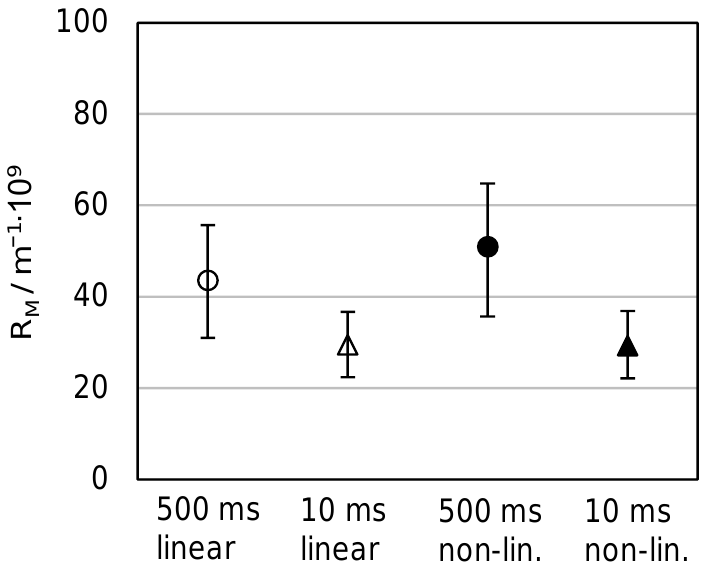
Processes 2023 , 11 , x FOR PEER REVIEW